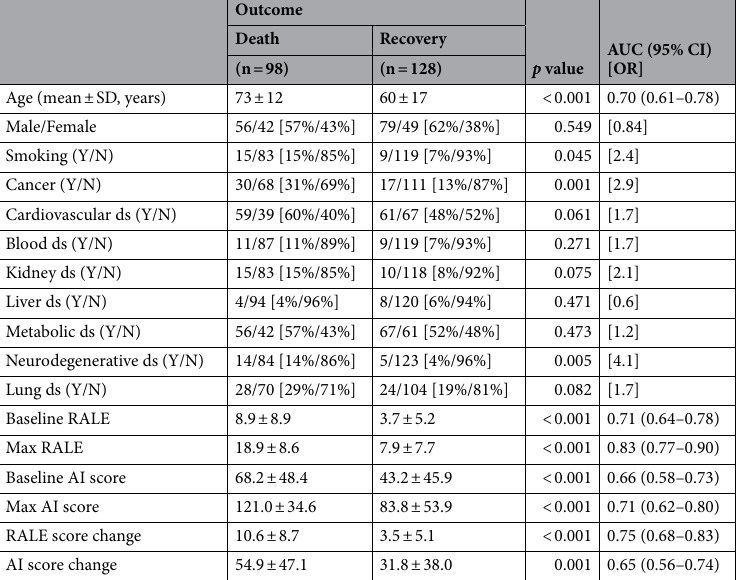
Mechanical ventilation [OR]Yes No (n =